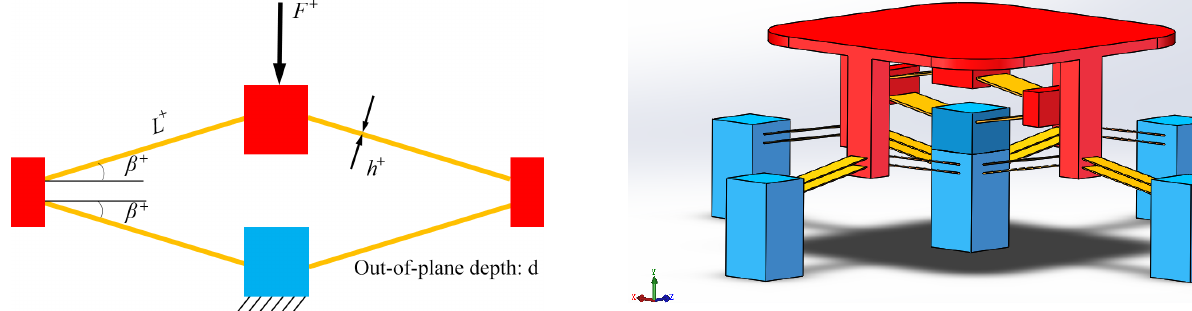
Figure 11. The conceptual design of the quasi-zero stiffness com- pliant mechanism. The red, yellow and blue parts represent the mov- ing platforms, the tilted flexure beams and the fixed bases, respec- tively. Table 3. The parameters of the positive-stiffness mechanism.